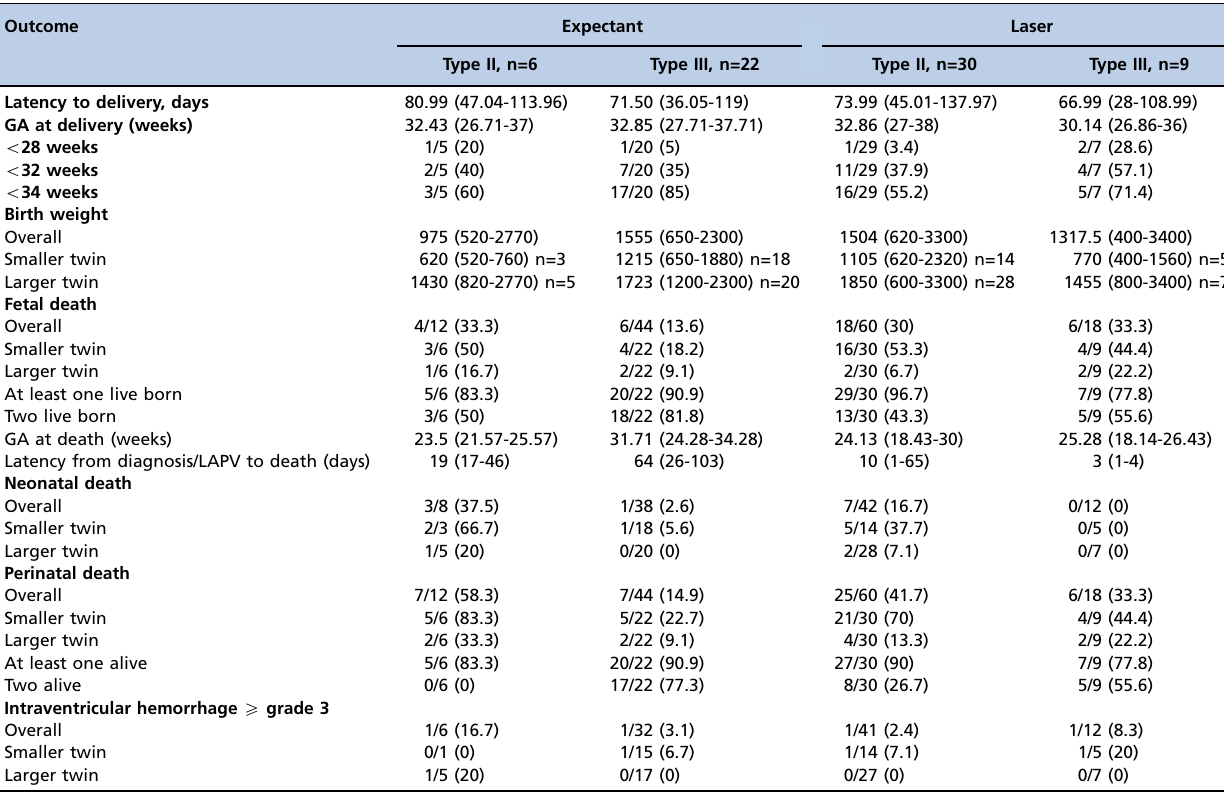
Table 2 - Perinatal outcomes of monochorionic twin pregnancies with type II or III Doppler patterns according to management strategy (expectant management or laser ablation of placental vessels). Outcome